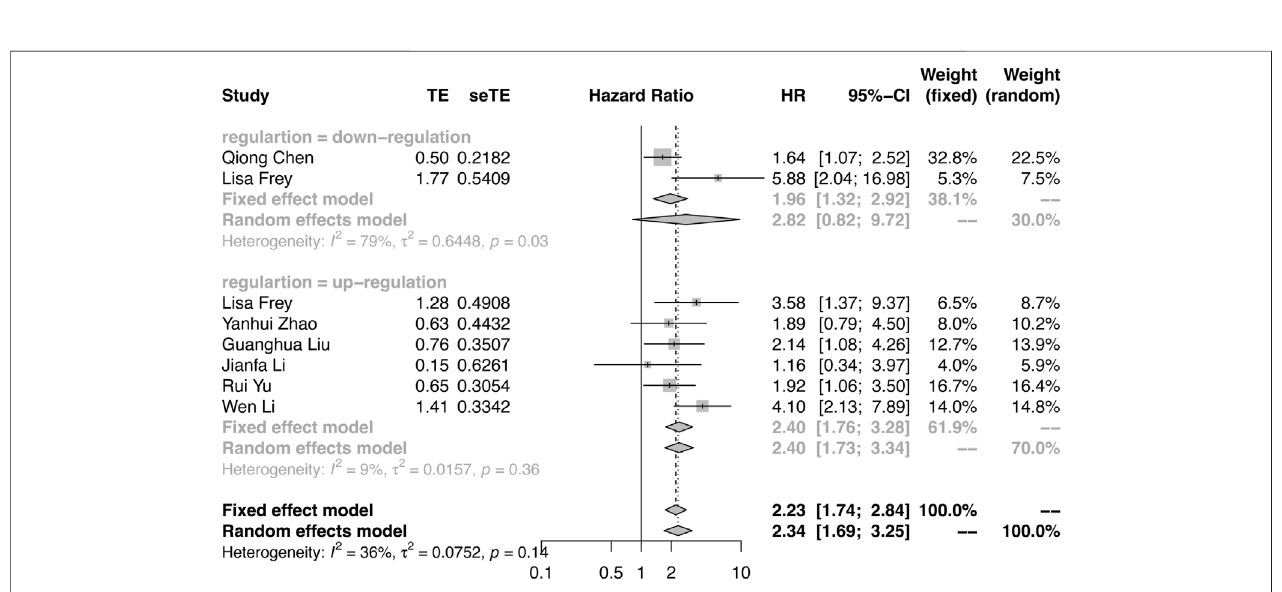
FIGURE 3 | Forest plots verify the association between the expression of circRNAs and progression-free survival (PFS). High expression of oncogenic circRNAs and low expression of tumor-suppressor circRNAs were associated with poor PFS.